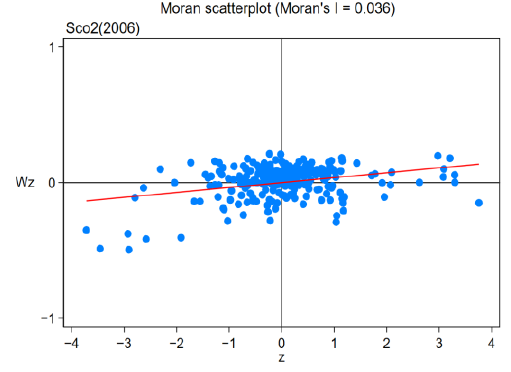
Figure 9. Moran Scatterplot (2006).